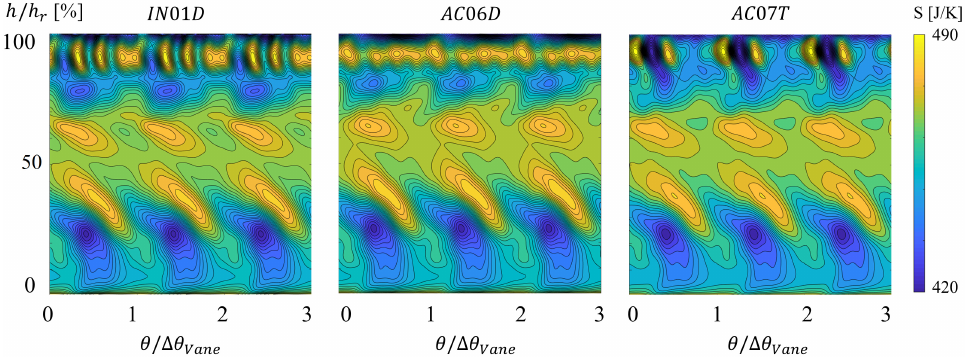
Figure 9. Contours of time-average outlet entropy in the vane frame of